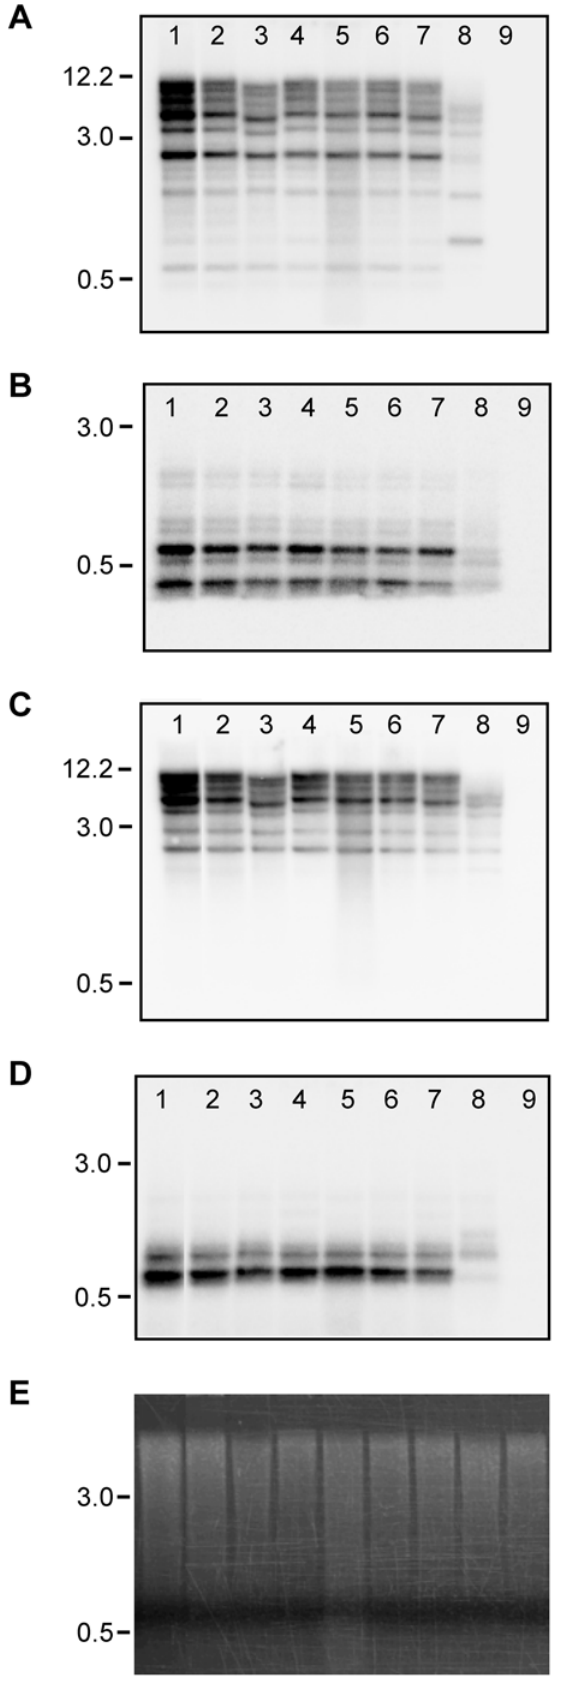
Figure 5. Southern blot analyses of selected Pinus species. The location of probes Fr1035 and Fr1075 in RLG_ Gymny _EU912388-1 are indicated in Figure 1. (A, B) filters hybridized with Fr1075 probe; (C, D) filters hybridized with Fr1035 probe; (A, C) digested with Hin dIII; (B, D) digested with Hae III; (E) representative Hin dIII digested DNA stained with ethidium bromide. Lanes (1) Pinus glabra , (2) P. taeda , (3) P. elliottii , (4) P. radiata , (5) P. echinata , (6) P. palustris , (7) P. virginiana , (8) P. pinea , (9) P. strobus .